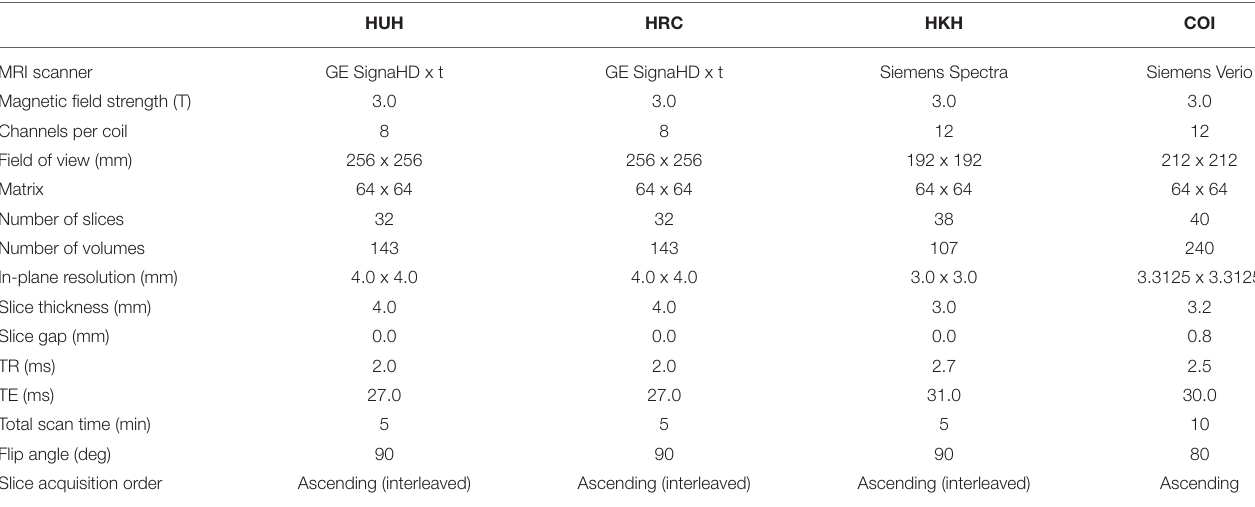
TABLE 2 | Imaging protocols for different fMRI recording sites in